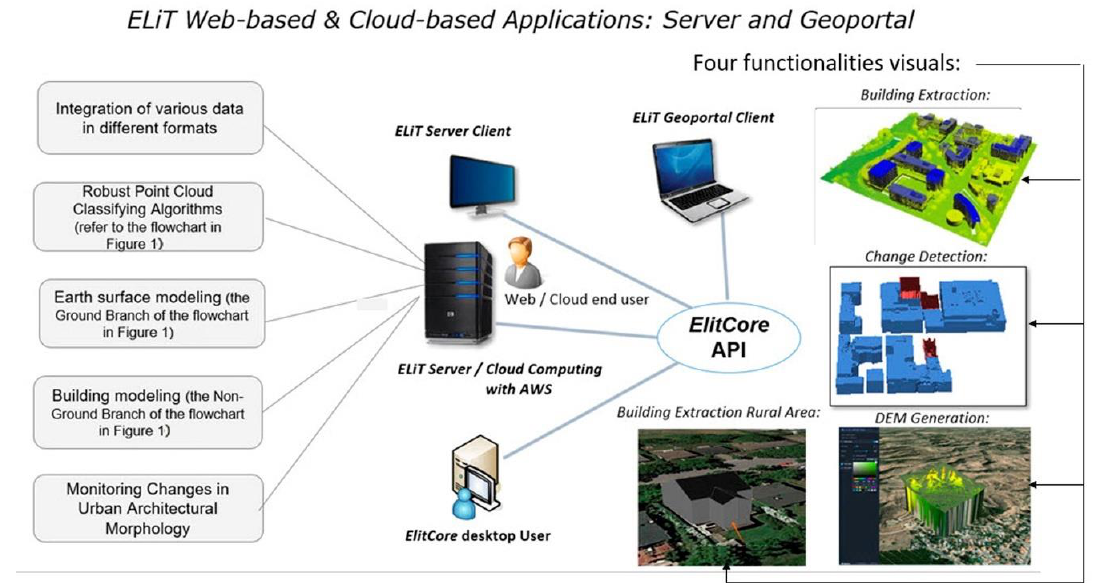
Figure 3. A general architectural scheme of the EOS LIDAR Tool ( ELiT ) software family: the ELiT Core desktop, the ELiT web-based Server, and the cloud-based ELiT Geoportal.